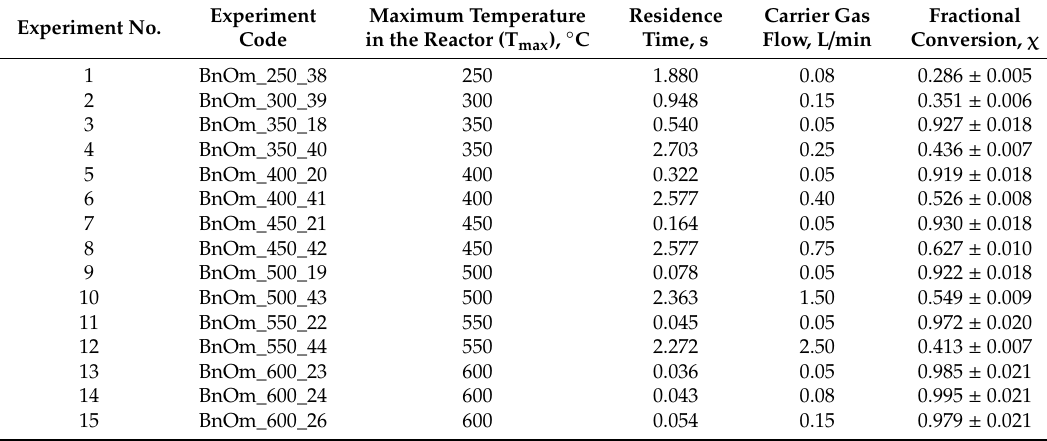
Table 3. Results of the kinetic measurements of O-methyl-N-benzyl carbamate thermolysis (1c). Experiment